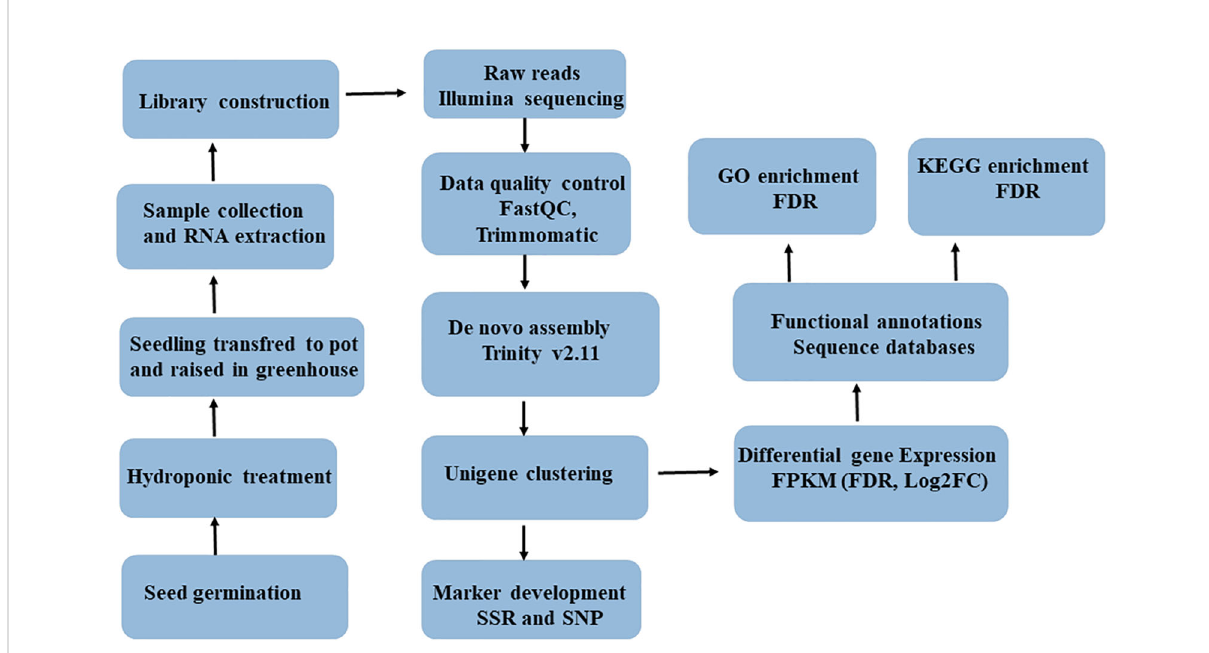
FIGURE 1 Complete work fl ow of RNA-seq data acquisition and analysis involving six fi nger millet genotypes (AT1, AT2, AT3, AS1, AS2 and